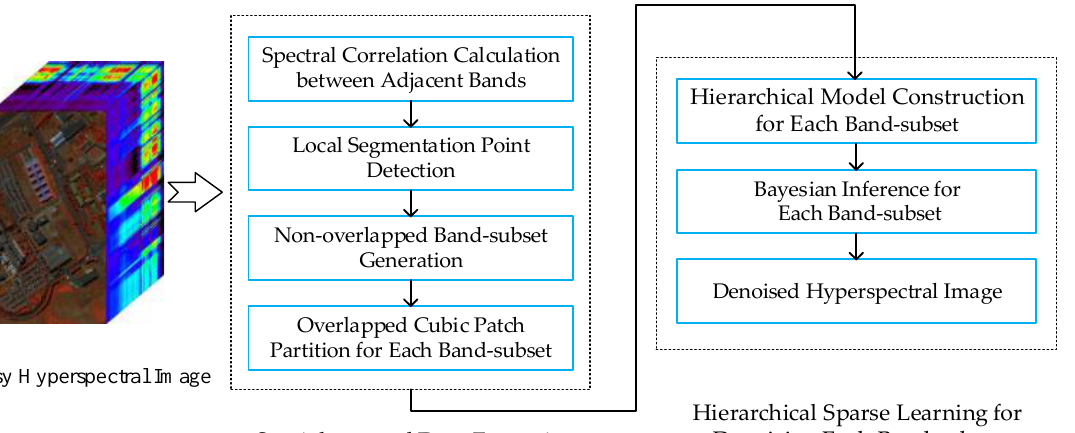
Figure 1. Framework of the proposed approach.